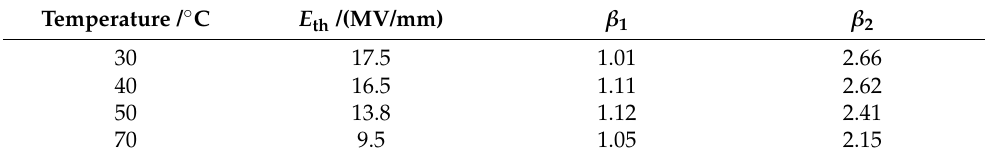
Table 4. Electric conduction characteristic parameters of EPDM-g-GMO at various temperatures. Temperature / ◦ C